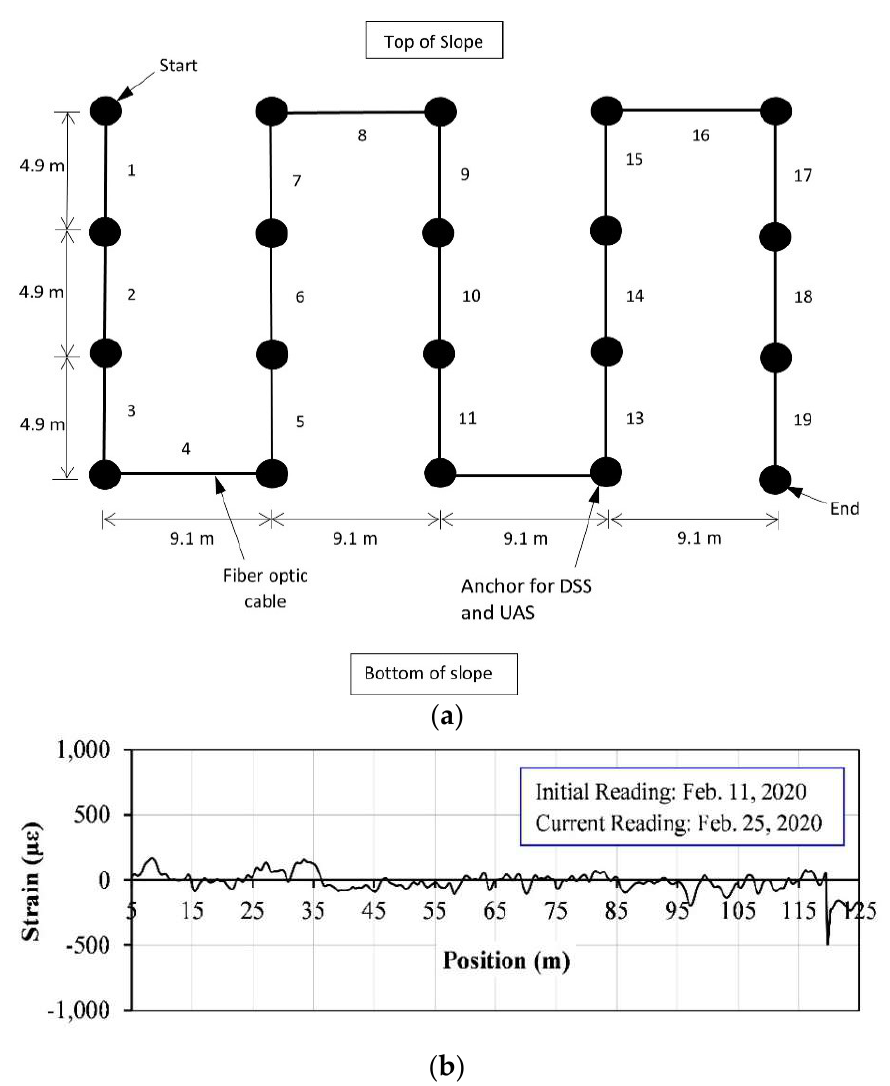
Figure 10. Instrumentation on Highway 84 slope. ( a ) Alignment of DSS line (Large solid circle: PVC Pole, Black Line: DSS line). ( b ) Measured Strain by DSS.